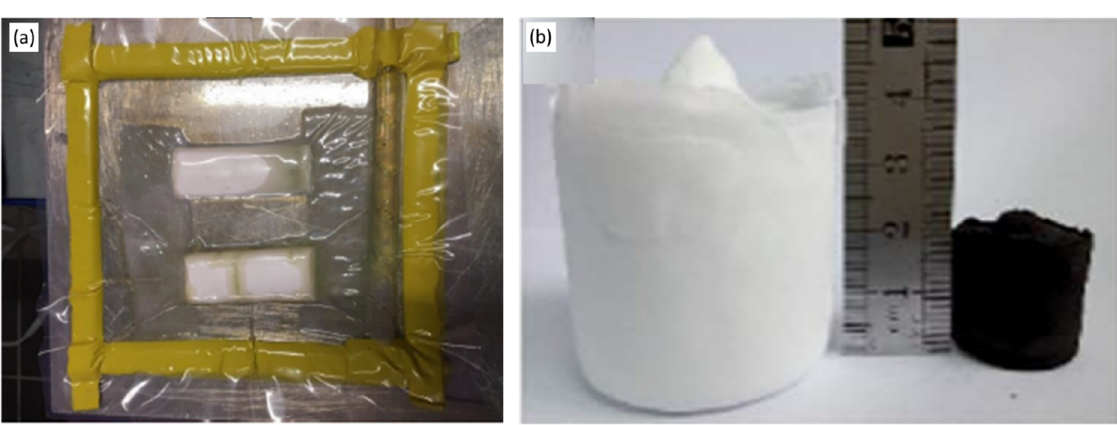
Figure 9. Examples of post‐treatment processes of ice‐templated porous nanocellulose‐based materials. ( a ) Vacuum infusion of a CNF foam with an epoxy resin to obtain a composite material (Adapted from Nissilä et al. [133] with permission from Elsevier). ( b ) Photograph of a carbon foam (black sample on the right) obtained from the pyrolysis of a CNF foam (sample on the left) under nitrogen flow. (Adapted from Wang et al. [134] with permission from the Royal Society of Chemistry).